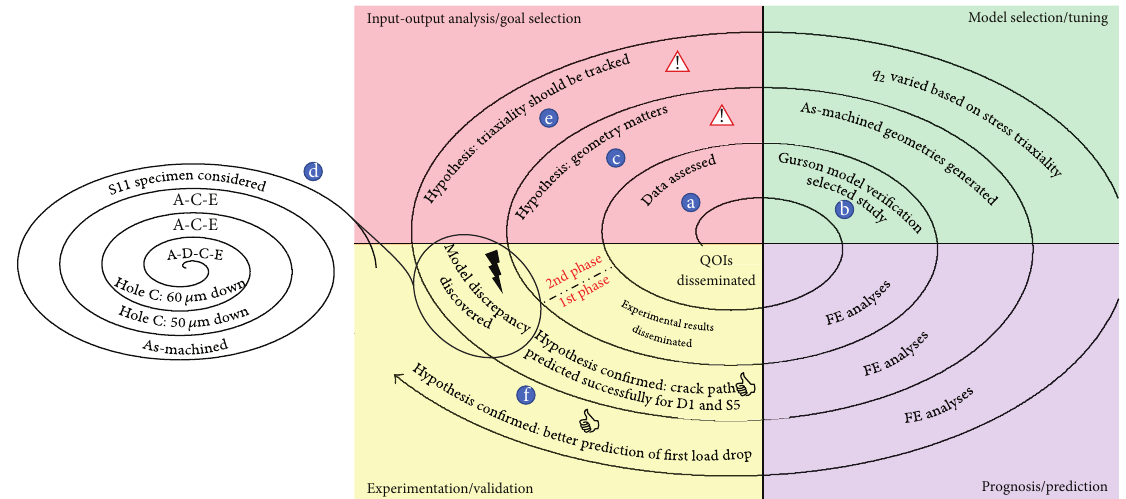
Figure 9: Spiral development diagram of both phases of the